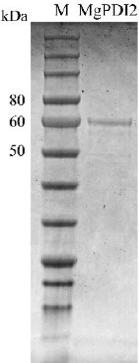
Figure 3. The 12% SDS-PAGE analysis of the purified MgPDI2 expressed in Escherichia coli BL21